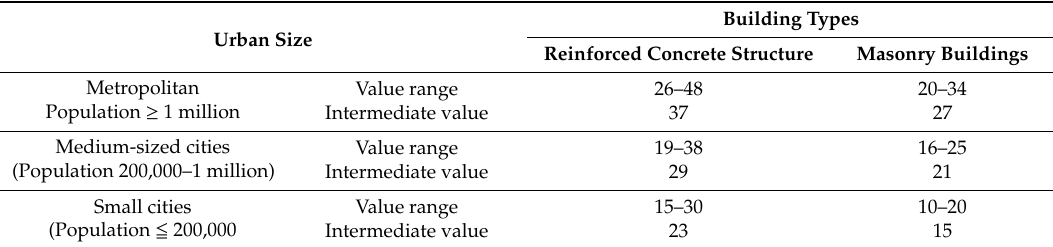
Table 7. Value ranges for the ratio coe ffi cients between the unit price to replace mid-to-high-end indoor decoration and the cost of the main structure (unit: %).